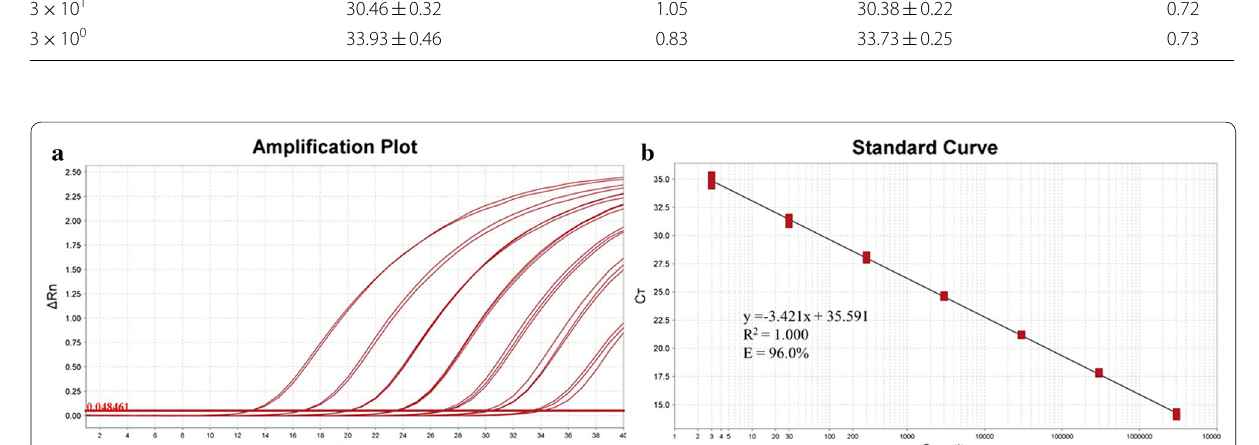
Fig. 3 A representative amplification plot ( a ) and standard curve ( b ) of O. scatoligenes Taqman-MGB qPCR assay with tenfold dilutions of O.